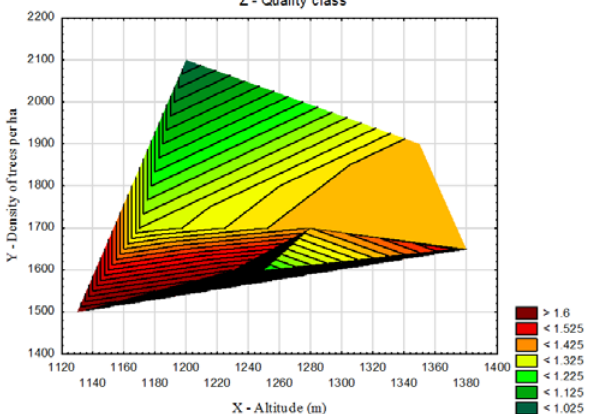
Fig. 4. The influence of altitude and density of the spruce trees on the quality wood class